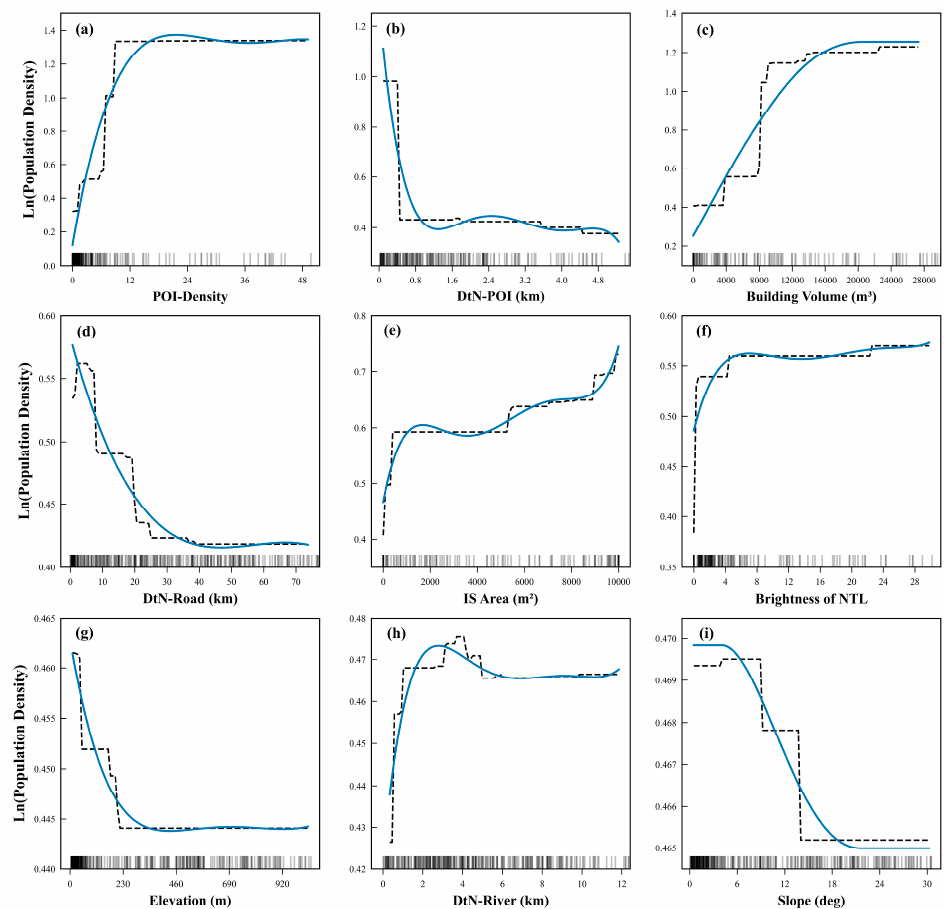
Figure 11. Partial dependency plots for the variables in the GXLS-Stacking model predicting popula- tion density ( a – i ). The black ticks at the bottom of the plots are the distribution density of the input variables. The solid blue line is the fitted